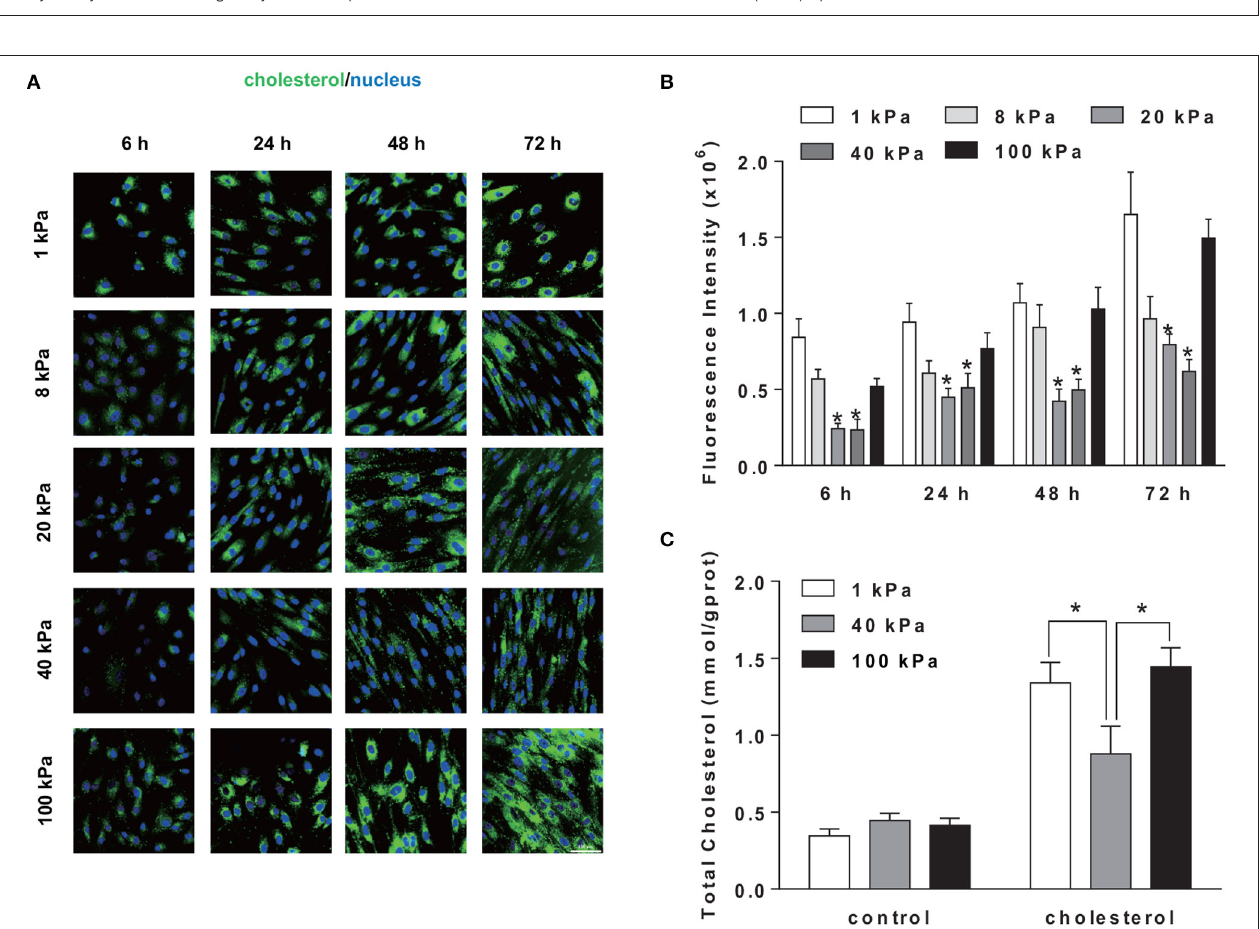
FIGURE 1 | bar = 50 µ m) and quantitation by colorimetric analysis ( n = 3) (in B ). (D,E) SMCs were treated with 20 µ g/ml Chol: M β CD for 72 h, the mRNA expression level of SMC marker (ACTA2) and macrophage markers (CD68 and LGALS3) was measured by RT-qPCR. GAPDH was used as the internal control for normalization ( n = 3). Fold change is the ratio of SMCs gene expression with and without (control) cholesterol treatment ( n = 3). (F) ACTA2 (red) and CD68 (green) protein expression was examined by immunofluorescence staining (blue: DAPI staining of nucleus, scale bar = 100 µ m). (G) ACTA2 and CD68 protein expression was